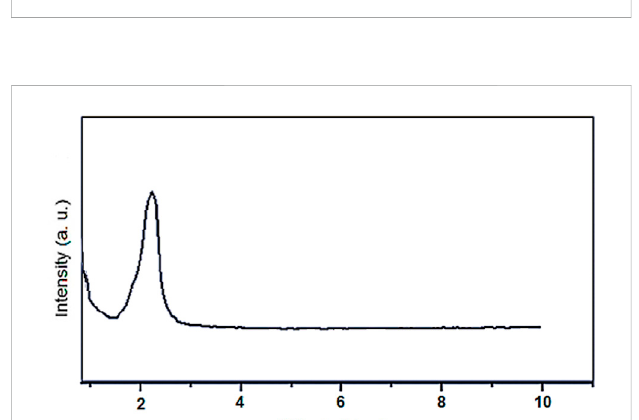
FIGURE 3 Wide-angle PXRD of Fe 3 O 4 @PMO/SB-Pd.